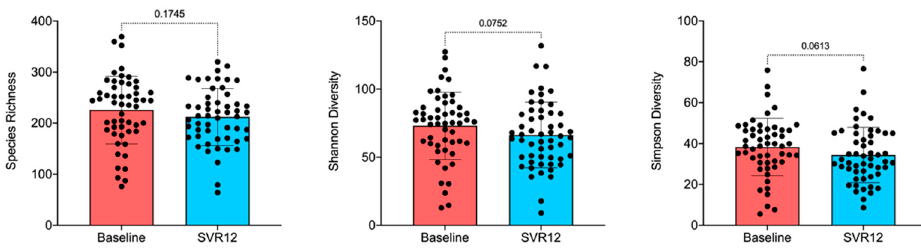
Figure 2. Overall species richness comparison of before treatment (baseline) and SVR12 groups. In this analysis, p < 0.05 was considered significant. Box-and-whisker plots display quartiles and range. SVR12 = sustained virologic response 12 weeks after the end of the treatment.